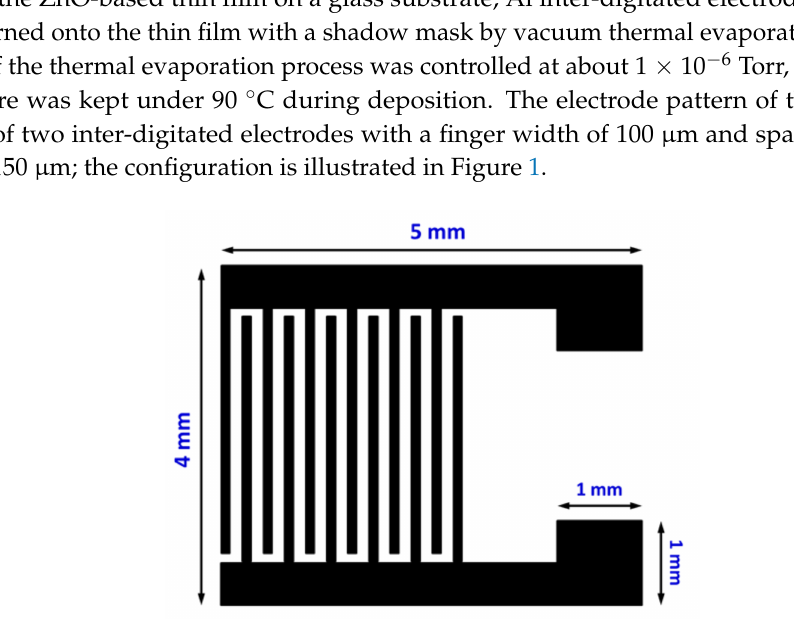
Figure 1. Schematic pattern of interdigital (IDT) electrodes of the ZnO-based metal-semiconductor-metal (MSM)